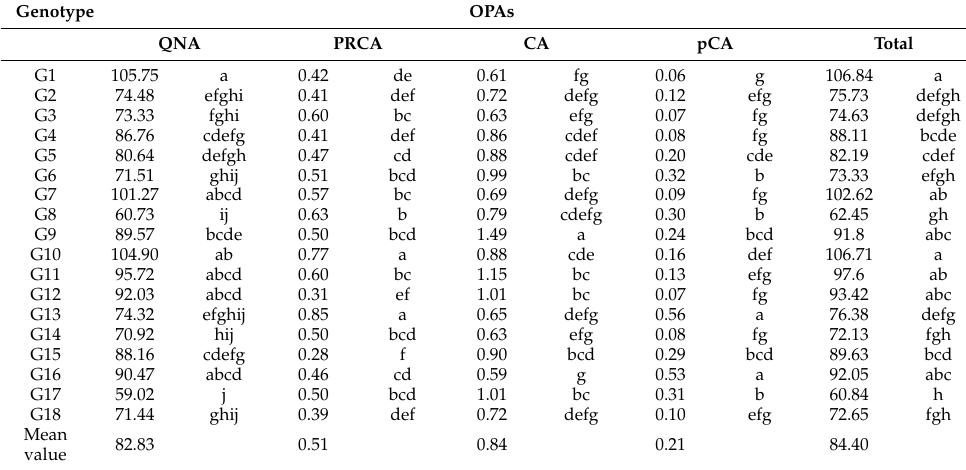
Table 6. Content (mg/100 g of dw) of other phenolic acids (OPAs) of 18 native Greek rock samphire genotypes (for abbreviations and origin, see Table 1). Different letters in the same column characterize significant differences among genotypes according to Tukey’s test for p ≤